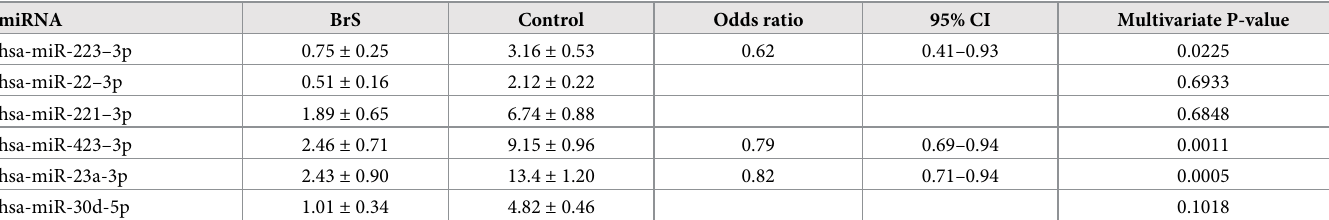
Table 2. Multivariate analysis of significant miRNAs expression in univariate analysis between BrS patients and controls. miRNA